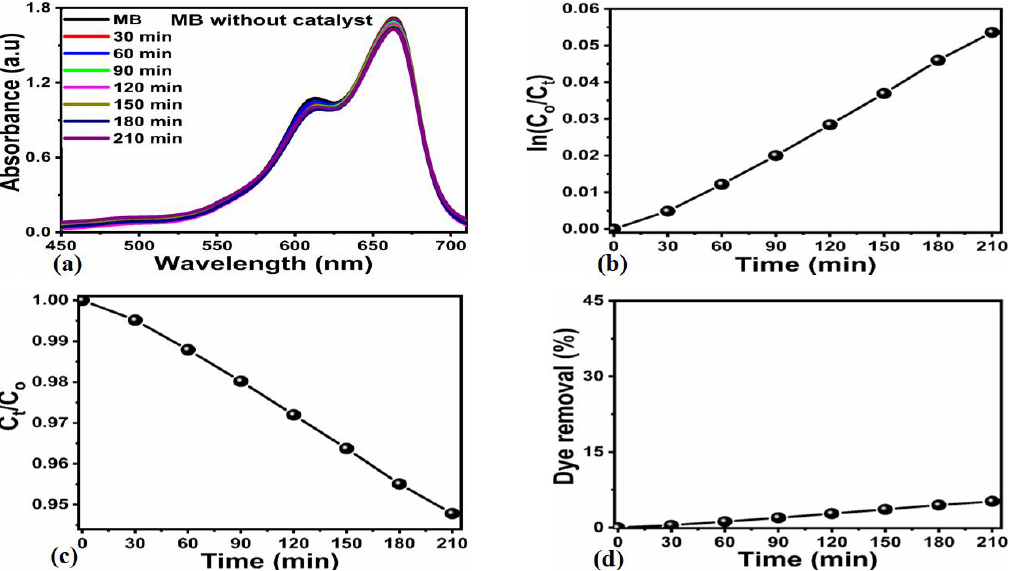
Figure 4. ( a ) UV-visible absorbance spectra measured in 8.22 × 10 −5 M MB solution in the absence of catalyst with the irradiation of natural sunlight for the time interval of 210 min, ( b ) Linear plot of ln( C t / C o ) against corresponding time of 210 min. ( c ) Linear plot of C t / C o . ( d ) Degradation efficiency of MB solution.